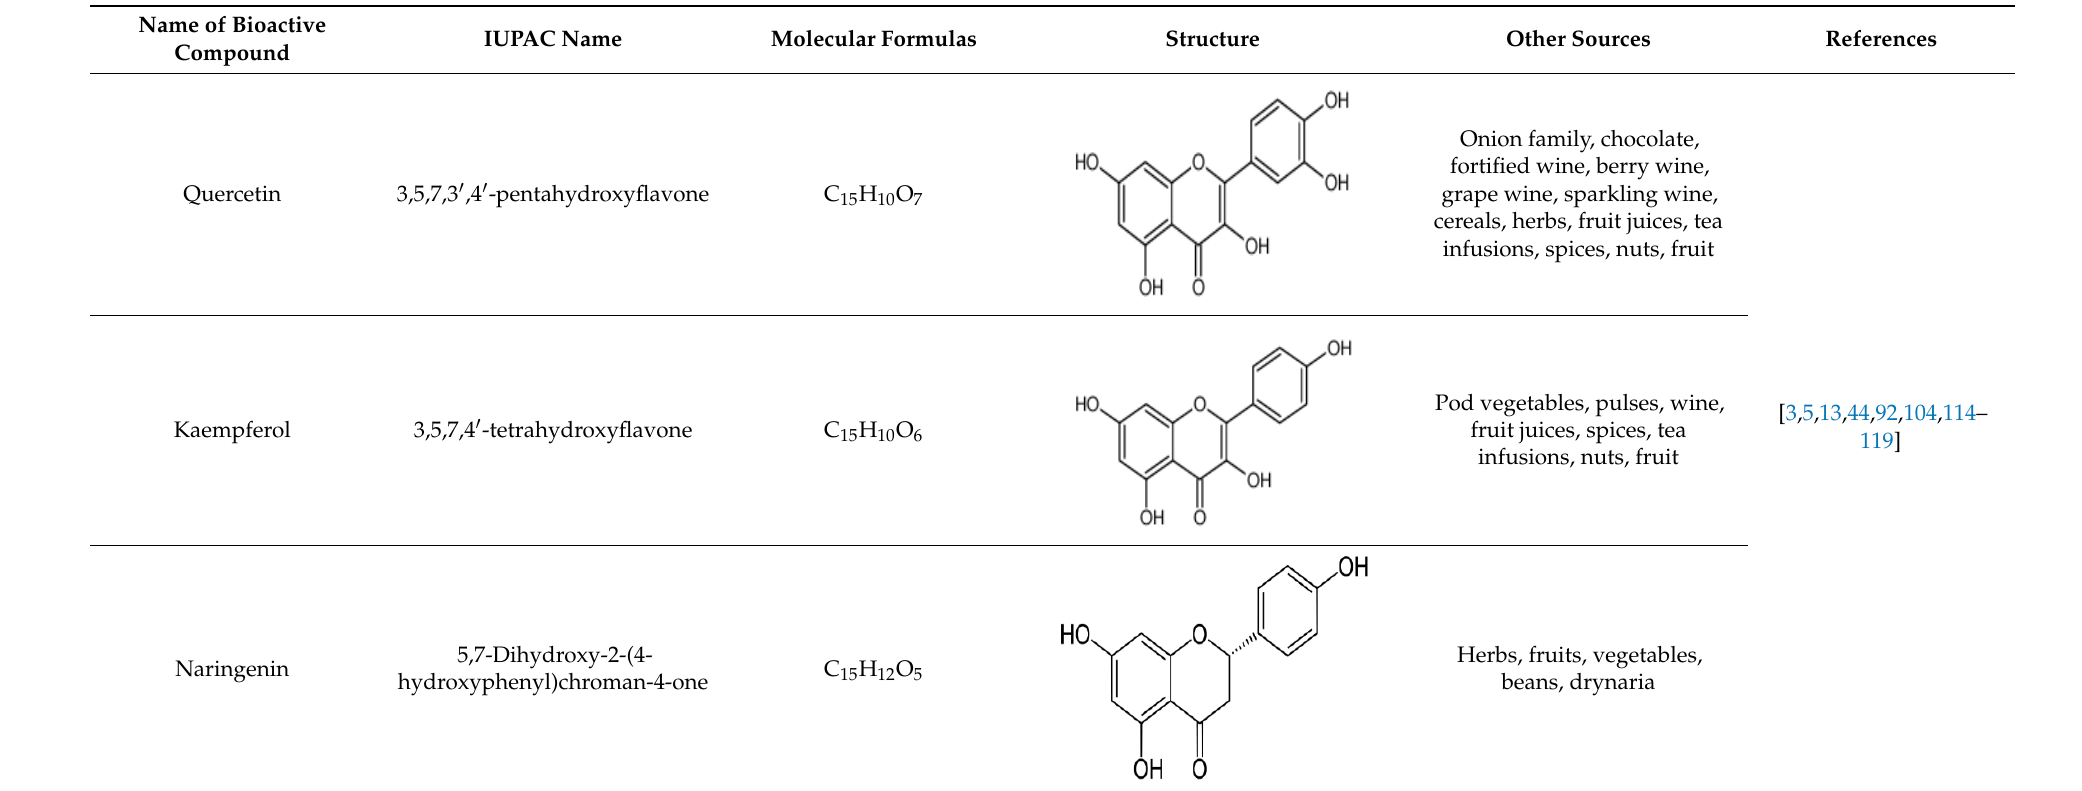
Table 9. Bioactive compounds in tomato.